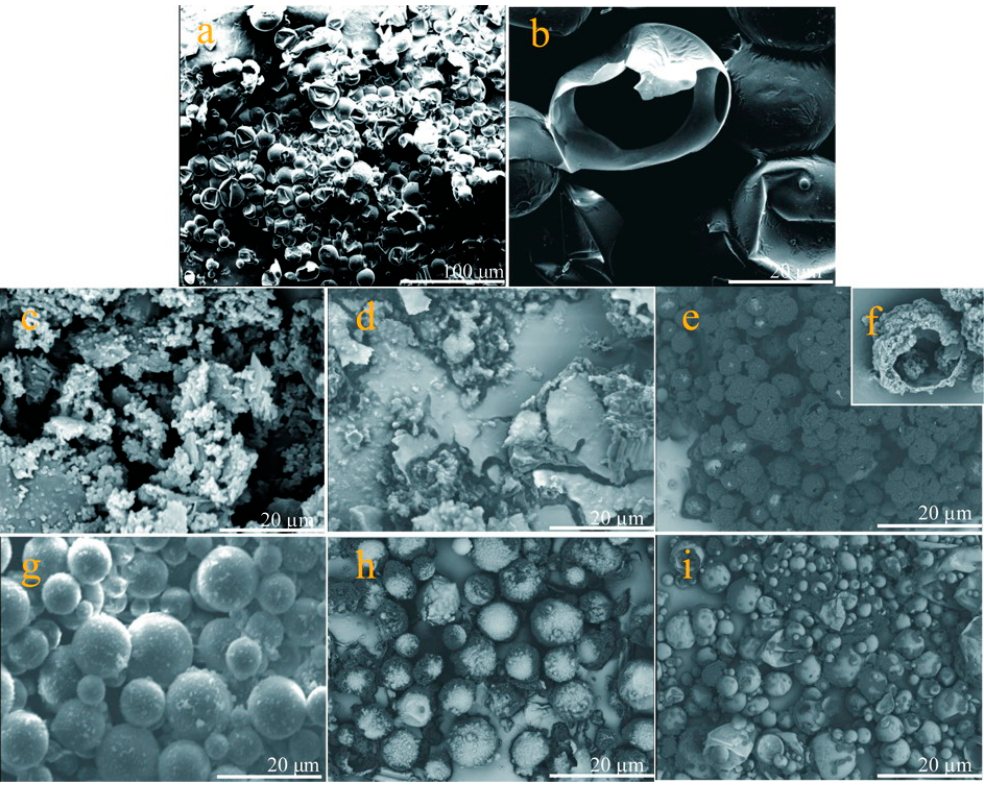
Figure 12. SEM morphologies of microcapsules under 300 °C, ( a , b ) M-0, ( c ) M-3, ( d ) M-4, ( e , f ) M-5, ( g , h ) M-6 and ( i ) M-7.